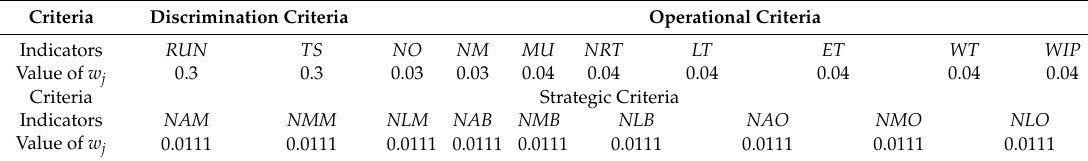
Table 3. Criteria weights ( wj